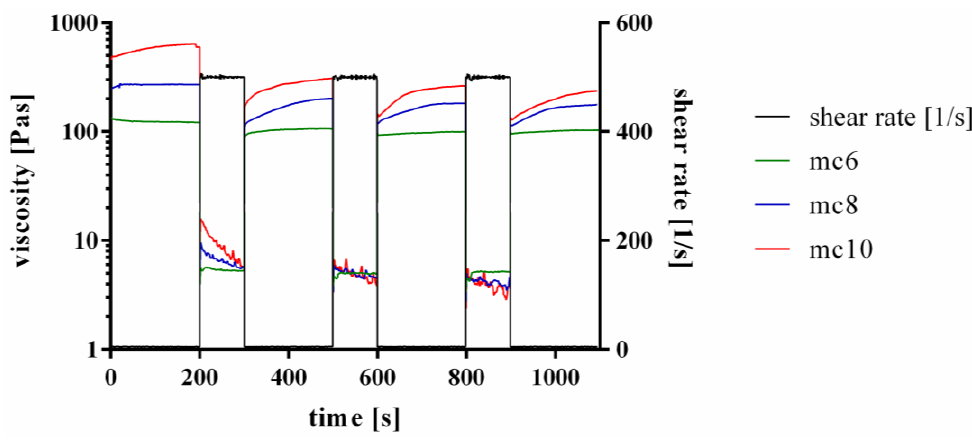
Figure 2. Representative curves of shear recovery experiments of mc6, mc8, and mc10 pastes.